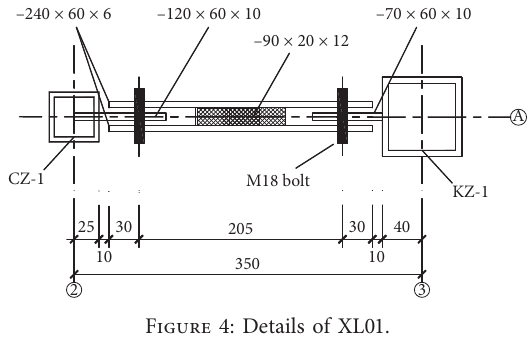
Figure 4: Details of